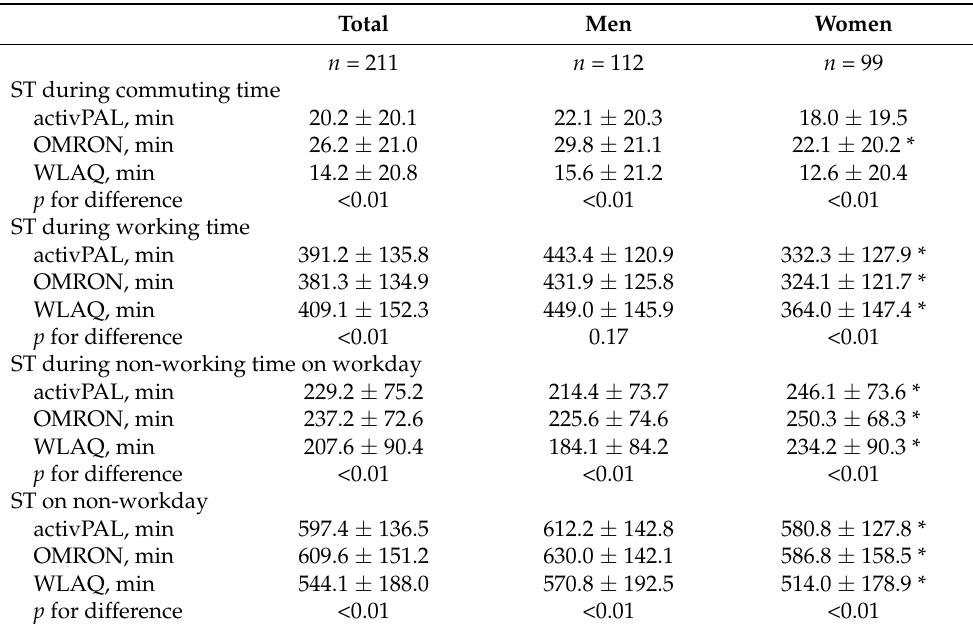
Table 1. Characteristics of participants and comparison with domain-specific sitting time measured by three measurement methods between the genders.